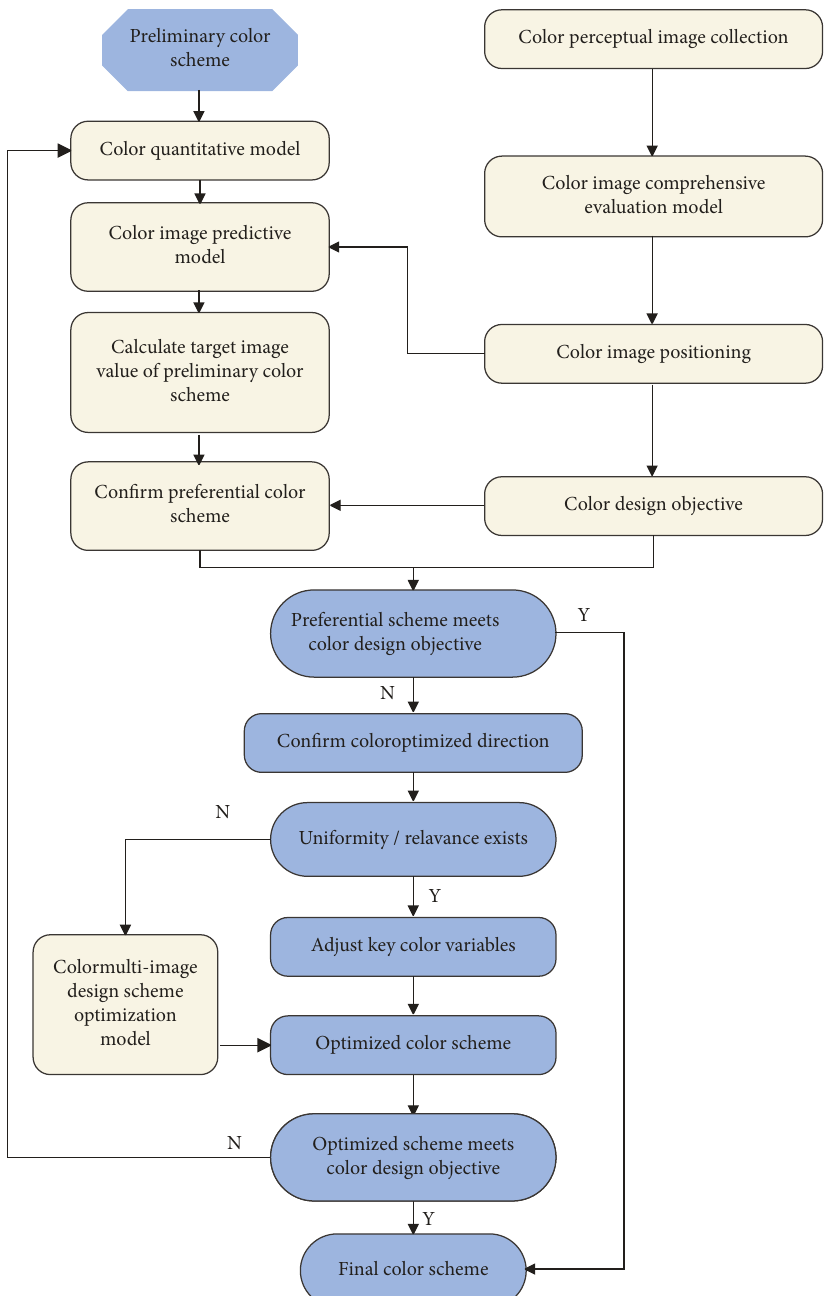
Figure 3: The process of color generation and evaluation of ceramic